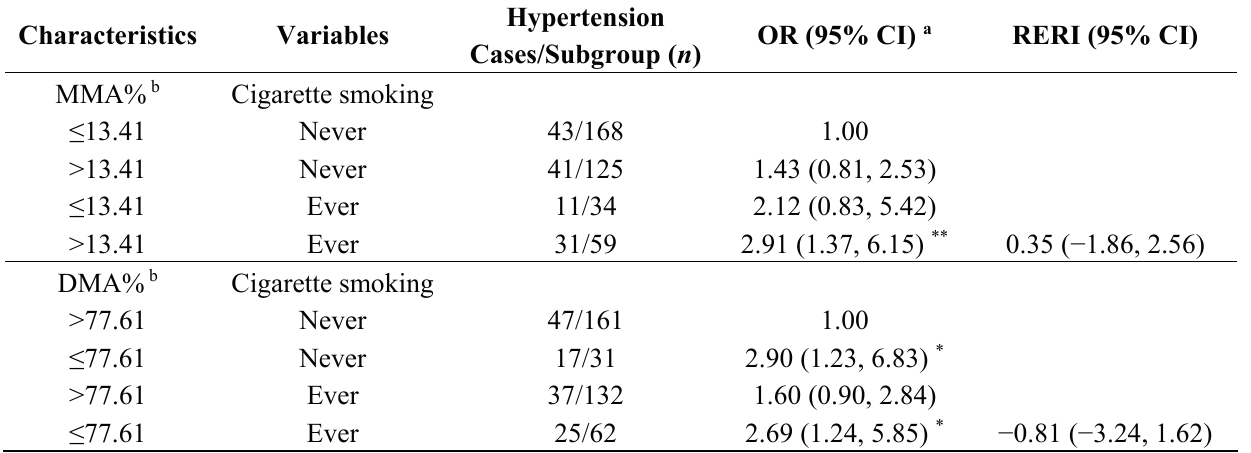
Table 4. The joint effects of urinary arsenic methylation indices with cigarette smoking on hypertension risk among subjects from arsenic-endemic area in Inner Mongolia, China ( n =